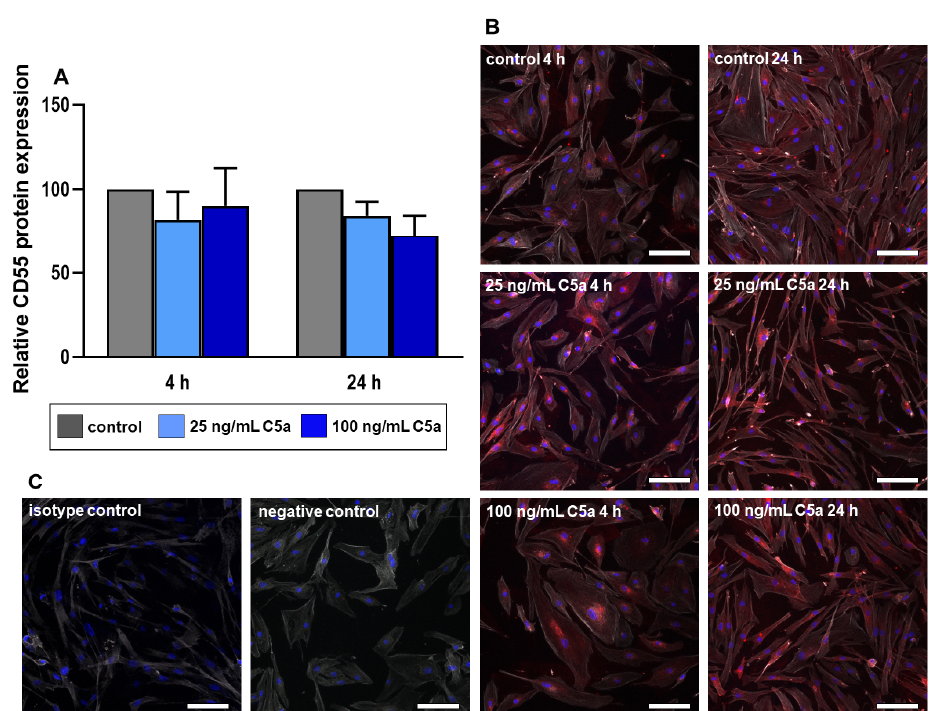
Figure 7. Tenocyte protein expression of CD55 after 4 and 24 h stimulation with 25 ng/mL (light blue) and 100 ng/mL (dark blue) recombinant C5a protein in comparison to the control group (grey) ( A ). Fluorescence intensity indicating CD55 immunoreactivity was analyzed using ImageJ. Mean values and the standard errors of mean are shown. Controls have been normalized to 1. Rout outlier test Q = 1.0%. Shapiro Wilk normality test was used to test the normal distribution of data. One sample t -test was performed in relation to control. ( B ) Representative images of tenocytes immunolabeled with CD55 specific antibodies. Red (Cy3) = CD55, blue (DAPI) = cell nuclei, grey (Phalloidin Alexa 633) = actin cytoskeleton. Scale bar = 100 µ m. ( C ) Isotype & negative controls of the immunofluorescence staining. n = 4 independent experiments with tenocytes from different